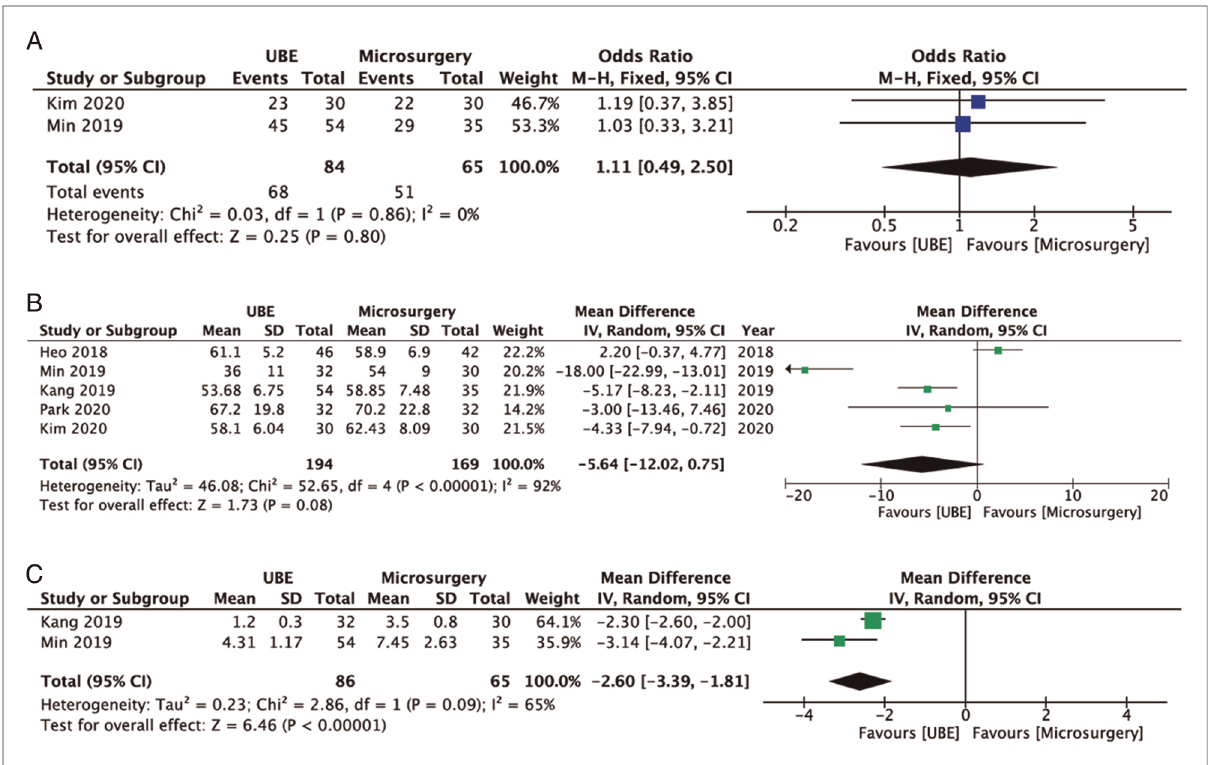
FIGURE 8 Forest plots comparing satisfaction rates ( A ), operative time ( B ), and length of hospital stay ( C ) between UBE ULBD and microscopic ULBD. UBE, unilateral biportal endoscopic; ULBD, unilateral laminectomy with bilateral